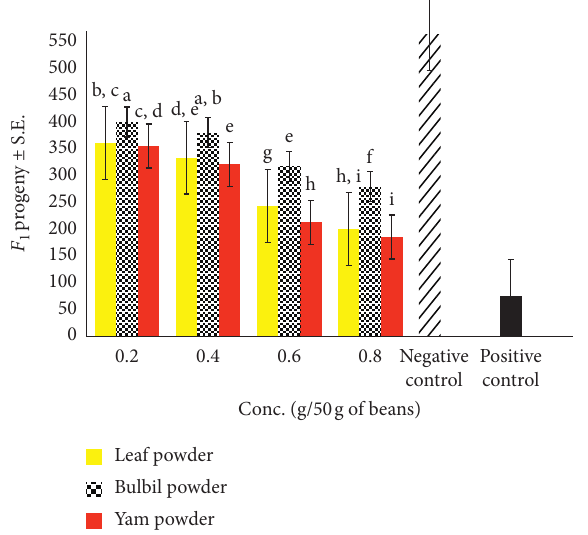
Figure 1: Emerging C. chinensis from P. vulgaris seeds treated with D. sansibarensis leaves, bulbils, and yams powders. Means in the graph that do not share a letter are significantly different ( N � 56; P < 0 .